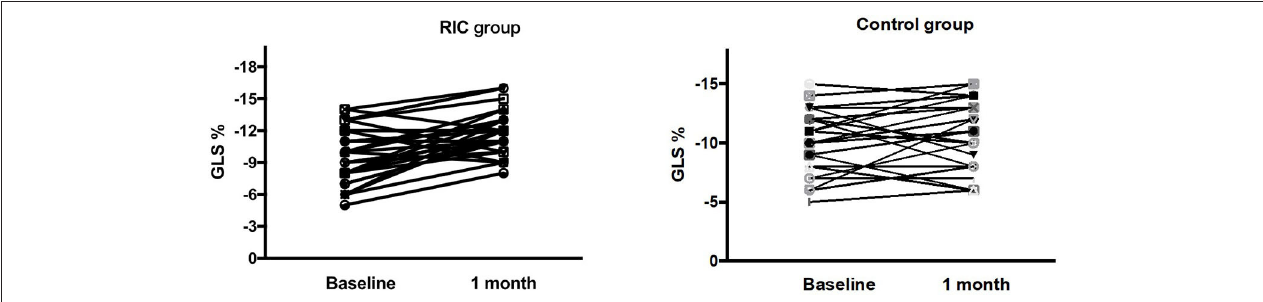
FIGURE 2 | Changes of GLS from baseline to 1 month in the RIC group and the control group. GLS, global longitudinal strain; RIC, remote ischemic conditioning.